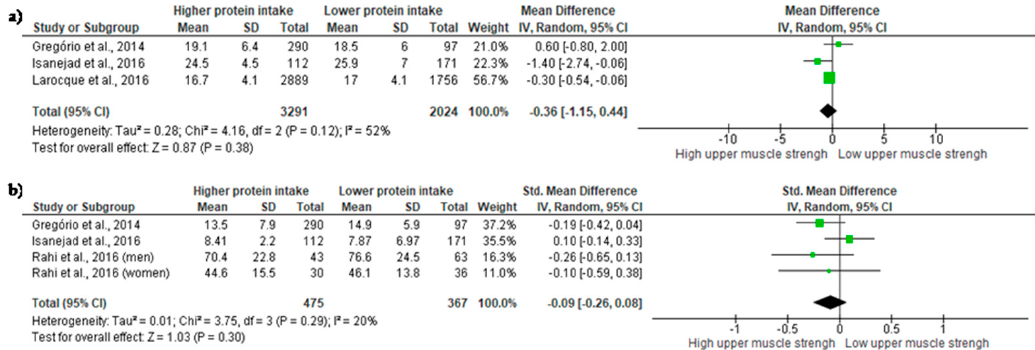
Figure 2. Mean difference in ( a ) Upper-limb muscle strength and Standardized mean difference in ( b ) Lower-limb muscle strength according to protein intake. Squares represent study-specific estimates; diamonds represent pooled estimates of random-effects meta-analyses.